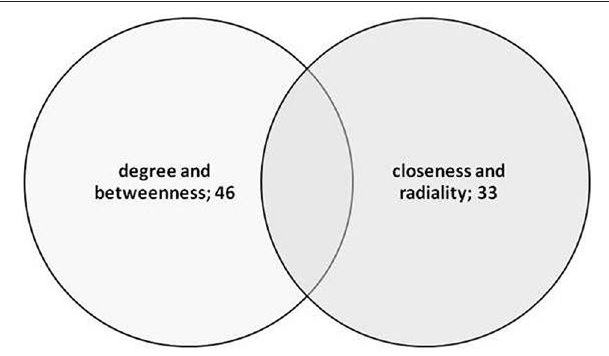
and closeness, radiality.